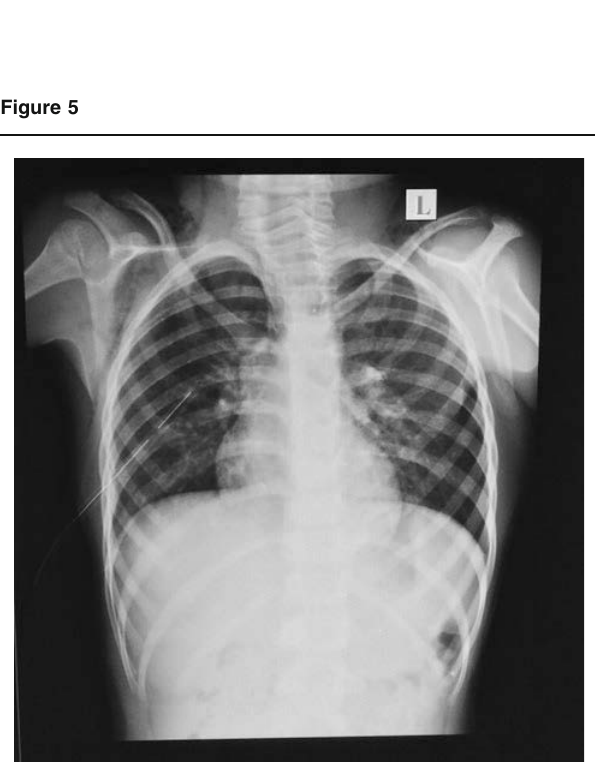
Chest radiograph after intercostal chest tube